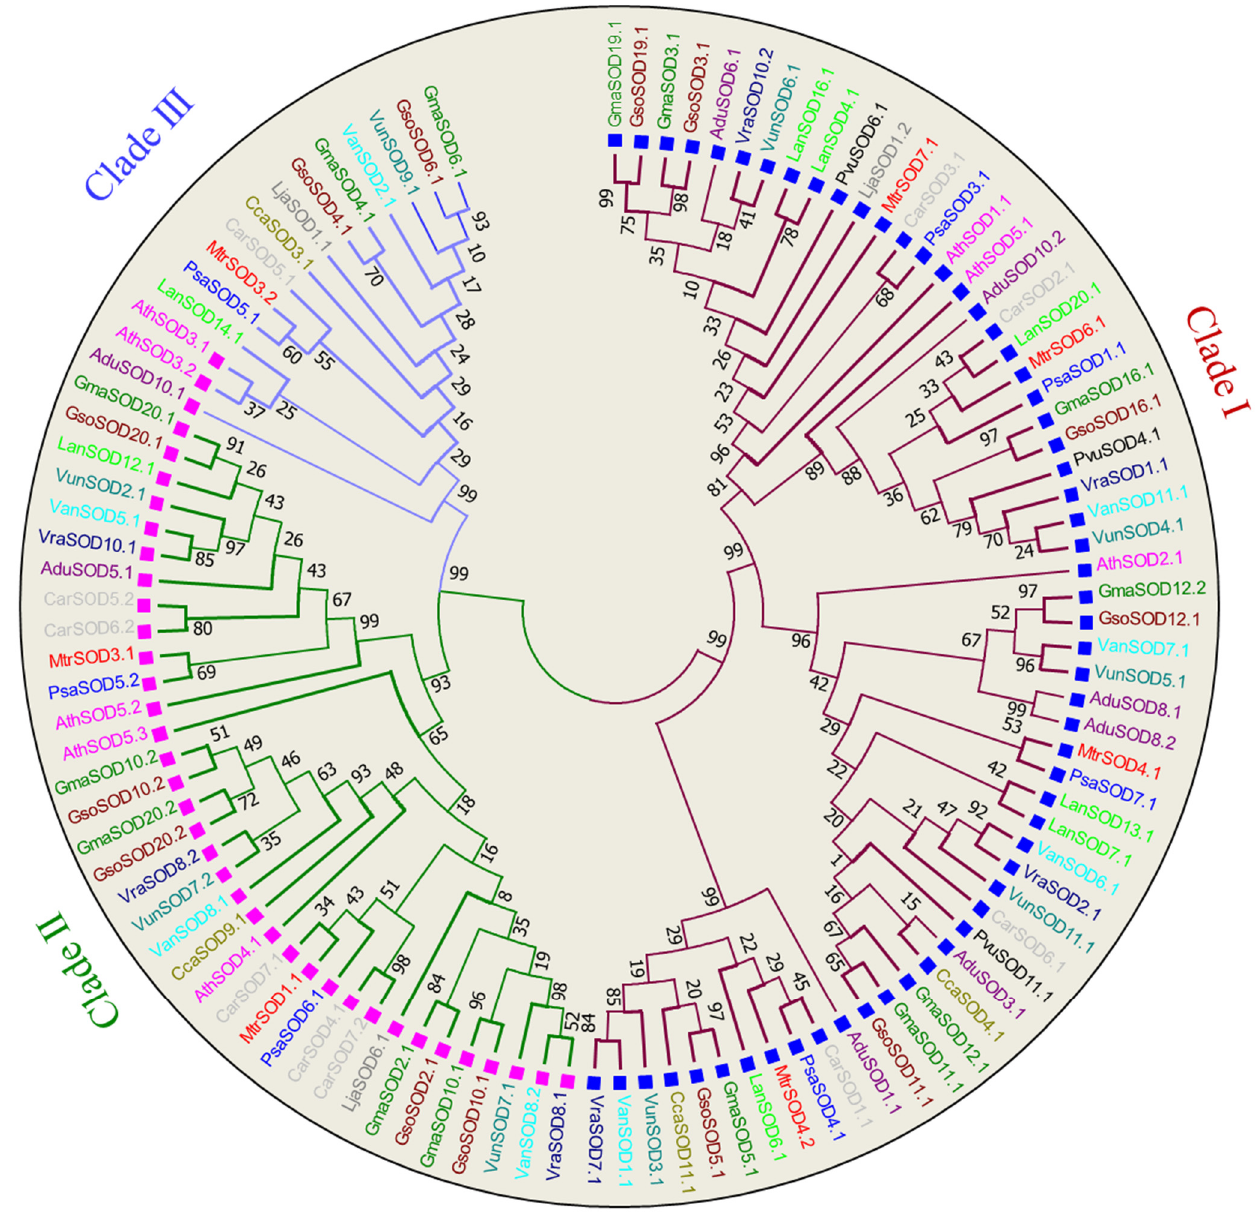
Figure 1. Phylogenic tree of SOD proteins. The tree was constructed in MEGA 7 by using the neighbor-joining method with 1000 bootstraps. Different clades of tree are marked with different colors: Clade I (Mahron), Clade II (Green), Clade III (Blue). The square shaped boxes represent the cellular localization: blue (cytoplasm) and pink (mitochondria).